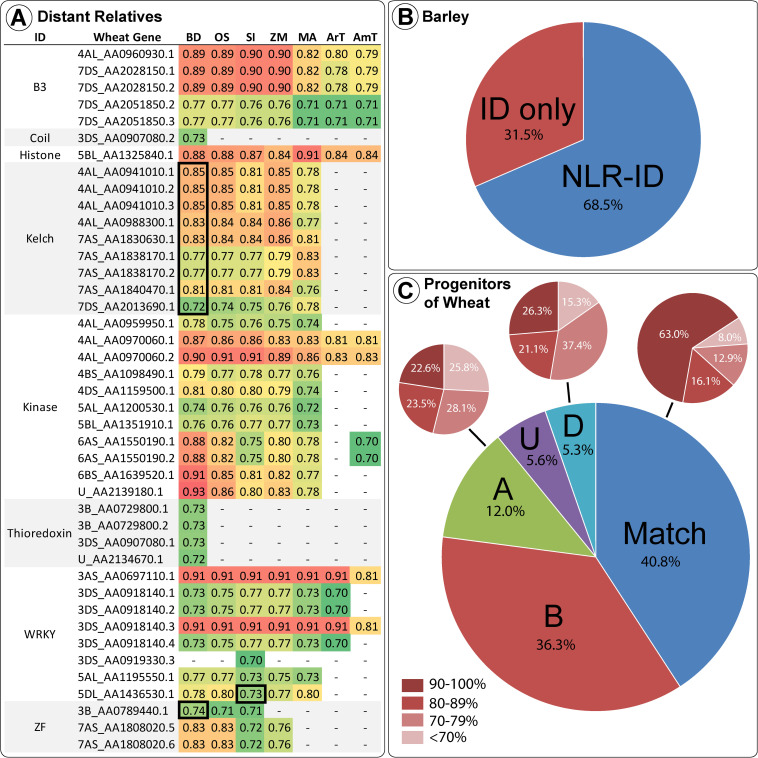
Wheat IDs and their homologs in wheat progenitors and other divergent monocot species are shown, including Arabidopsis thaliana and Amborella trichopoda.
(A) Sequence similarities above 70% are shown between wheat IDs and their homologs in Brachypodium (BD), rice (OS), foxtail millet (SI), maize (ZM), banana (MA), Arabidopsis (ArT), and Amborella (AmT). Wheat gene accession names are abbreviated to include information on chromosome arm and the last digits unique to each transcript. Sequence similarities of the NLR-ID homologs in other species are shown in the black-bordered boxes. (B) Barley ID homologs possessing and lacking NLR domains. (C) Mapping of homologs among wheat and wheat progenitors is displayed – a match between the progenitor and subgenome (labeled “Match”); subgenome A protein was more similar to an Aegilops tauschii sequence (labeled “A”); subgenome D protein was more similar to a TU sequence (labeled “D”); sequence was from the B subgenome with the unavailable AS progenitor (labeled “B”), or the accession subgenome is unknown (labeled “U”). Also, the level of homology between the pairs is demonstrated for “Match,” “A,” and “D,” with dark red corresponding to the proportion of sequences with high similarity (>90%) and lighter red corresponding to lower similarity (<70%).